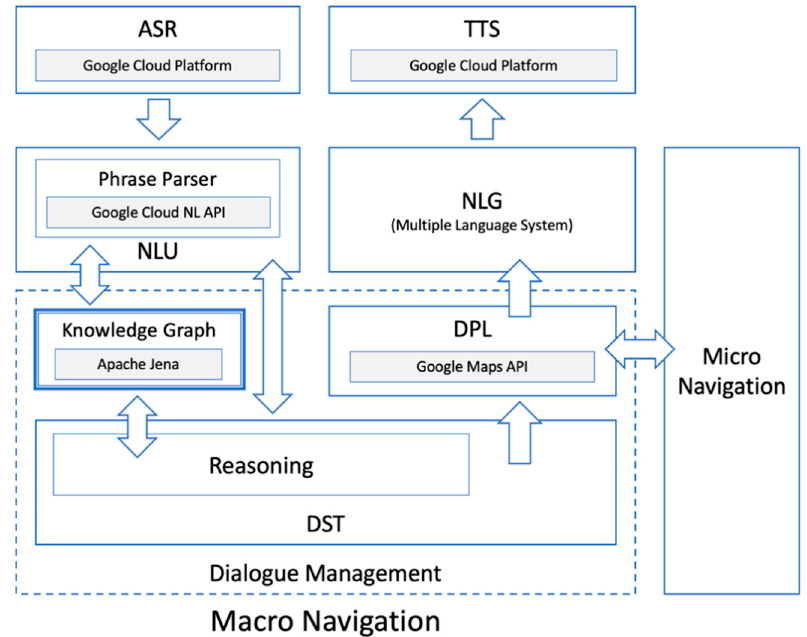
Figure 9. Macro-navigation system architecture based on knowledge graph.